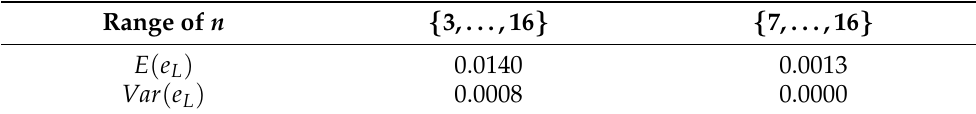
Table 4. The mean and estimated variance of the errors made when calculating P 1 n , by its limit formula, for two different ranges of n .